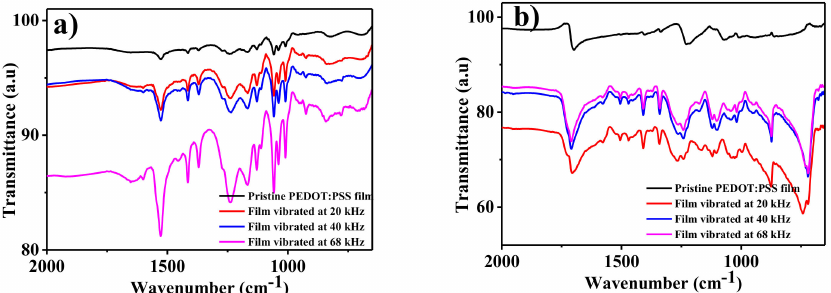
Figure 9. ATR-FTIR spectra of PEDOT:PSS films deposited on ( a ) glass/ITO and ( b ) on PET/ITO substrates. The vibration power is 5